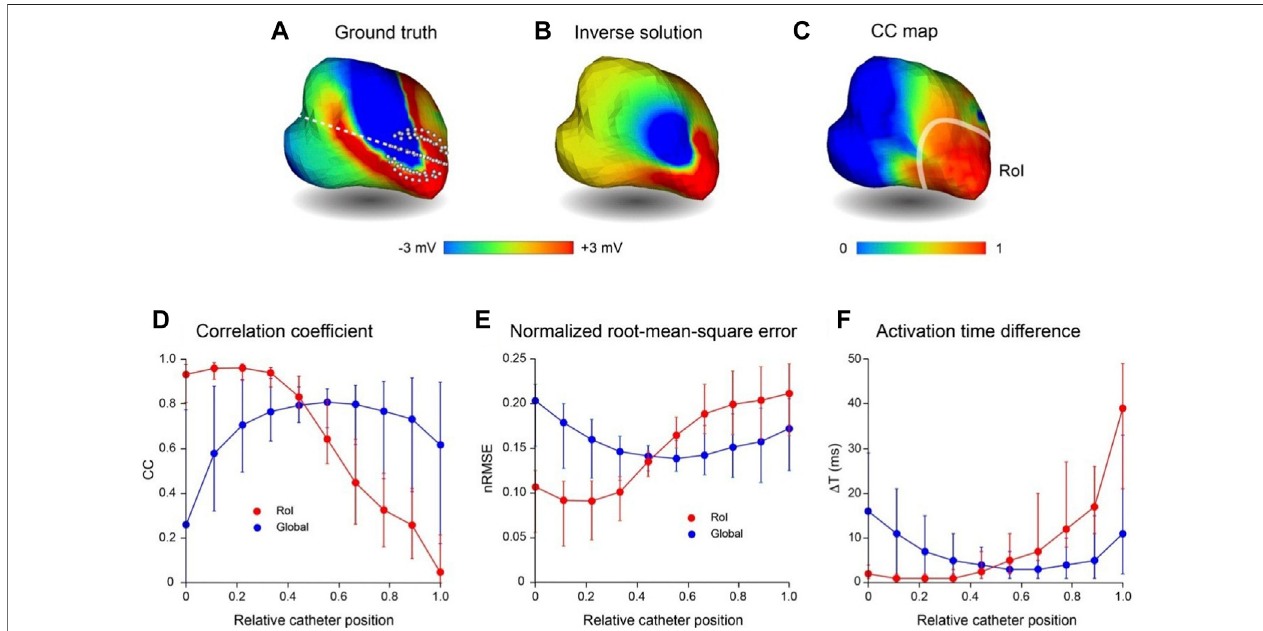
FIGURE 6 | Comparison of region-of-interest inverse potential mapping with global mapping. LA surface potentials during 3 activation cycles of simulated macroscopicreentrywere reconstructed from electrograms sampled inside theLA cavitywith asmall 64-electrode basket catheter. Thecatheterwasinitially positioned with some electrodes touching the wall at the junction with the LAA and then moved rightward until electrodes made contact with the inter-atrial septum. (A) Representativegroundtruthpotentials oncavitysurfacealso showingbroken whitelinealongwhichcatheterismoved fromoriginofLAA(relativecatheterposition 0) to inter-atrial septum (relative catheter position 1). (B) Inverse solution reconstructed from potentialssampled at relative catheter position 0. (C) Correlation coef fi cient map for ground-truth and inverse solutions in this case. The RoI indicated is the smoothed boundary of the surface in (C) where CC ≥ 0.9. In the lower panel (D – F) presentCC,nRMSEand Δ T,respectively,intheRoI(red)andacrossthecompleteLAsurface(blue)forinversesolutionswiththecatheteratequi-spacedlocationsalong thelinein (A) ;catheterlocations0and1areindicatedin (A) .Medianvaluesandinterquartilerange(IQR)aregiveninlowerpanel.Abbreviations:RoI,regionofinterest;LA, left atrium; LAA, left atrial appendage; CC, correlation coef fi cient; nRMSE,